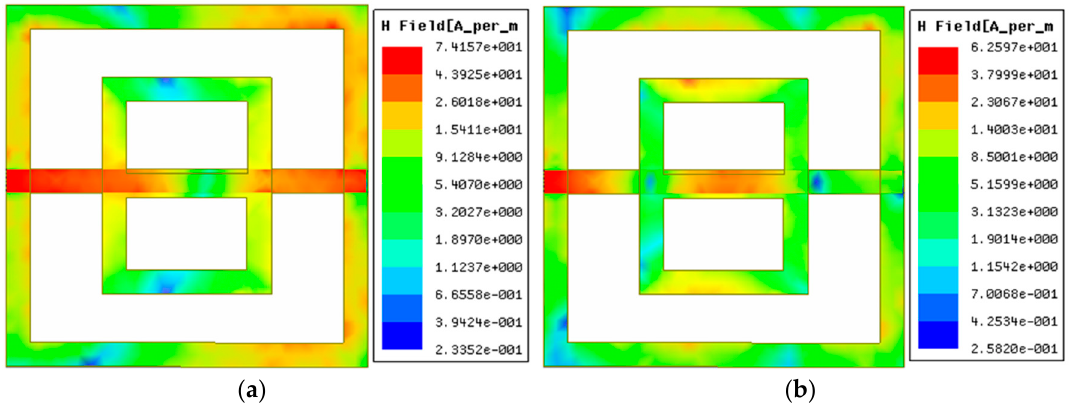
Figure 6. Magnetic field distribution of the sensor: ( a ) at 3.0 GHz, and ( b ) at 6.5 GHz.